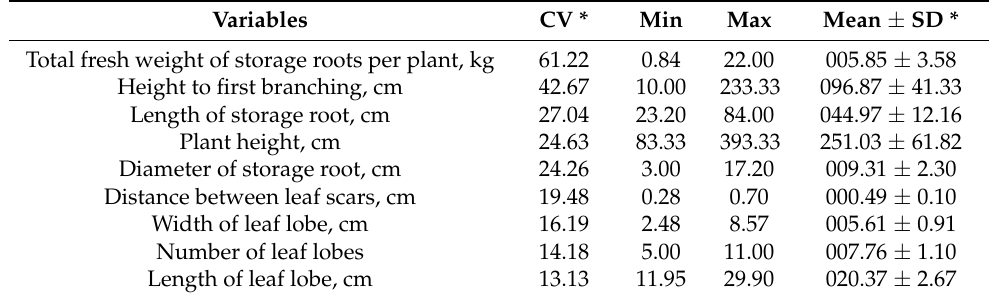
Table 1. Morphological variability with quantitative characters in the cassava collection from the Ecuadorian regions. Variables CV * Min Max Mean ± SD * Total fresh weight of storage roots per plant, kg 61.22 0.84 22.00 005.85 ± 3.58 Height to first branching, cm 42.67 10.00 233.33 096.87 ± 41.33 Length of storage root, cm 27.04 23.20 84.00 044.97 ± 12.16 Plant height, cm 24.63 83.33 393.33 251.03 ± 61.82 Diameter of storage root, cm 24.26 3.00 17.20 009.31 ± 2.30 Distance between leaf scars, cm 19.48 0.28 0.70 000.49 ± 0.10 Width of leaf lobe, cm 16.19 2.48 8.57 005.61 ± 0.91 Number of leaf lobes 14.18 5.00 11.00 007.76 ± 1.10 Length of leaf lobe, cm 13.13 11.95 29.90 020.37 ±